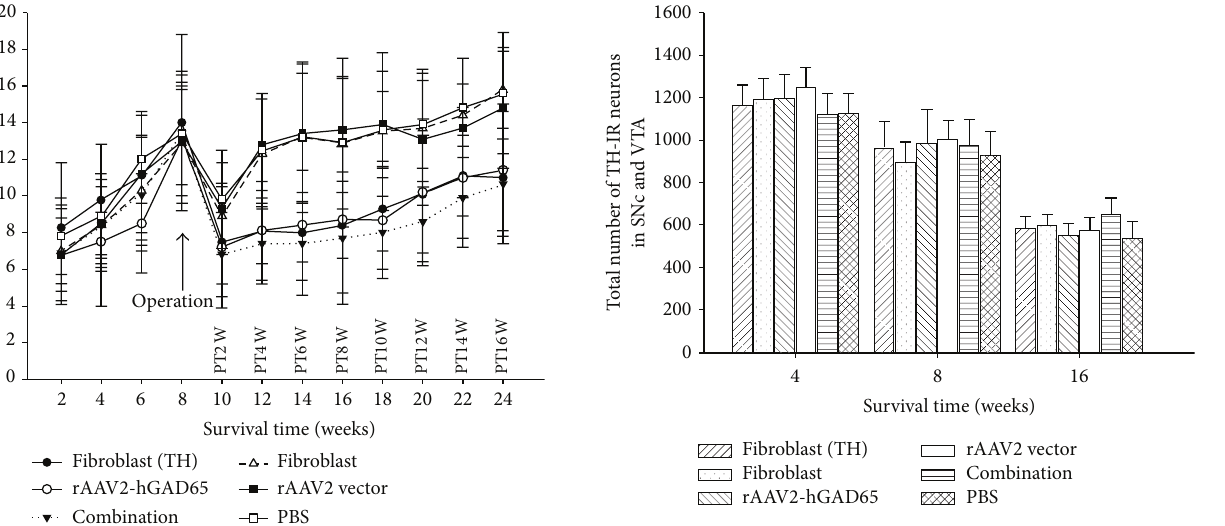
Figure 3: The rotation rate of the subgroup PD rats (arrow indi- cates the operation, intraSTN injection of rAAV2-hGAD65, rAAV2 vector, or PBS and/or intrastriatal injection of fibroblasts (TH), fibroblast). The cycles of the rats of combination group were a little lower than that of rAAV2-hGAD65, or fibroblasts (TH) groups, but there were no statistical differences between them ( 𝑃 > 0.05 , 𝑛 = 10 ). The cycles of the rats of combination, rAAV2-hGAD65, or fibroblasts (TH) groups were all significantly lower than that the control groups (fibroblasts, rAAV2 vector or PBS groups) from 4 to 16 weeks after treatment, respectively ( 𝑃 < 0.01 , 𝑛 = 10 ).